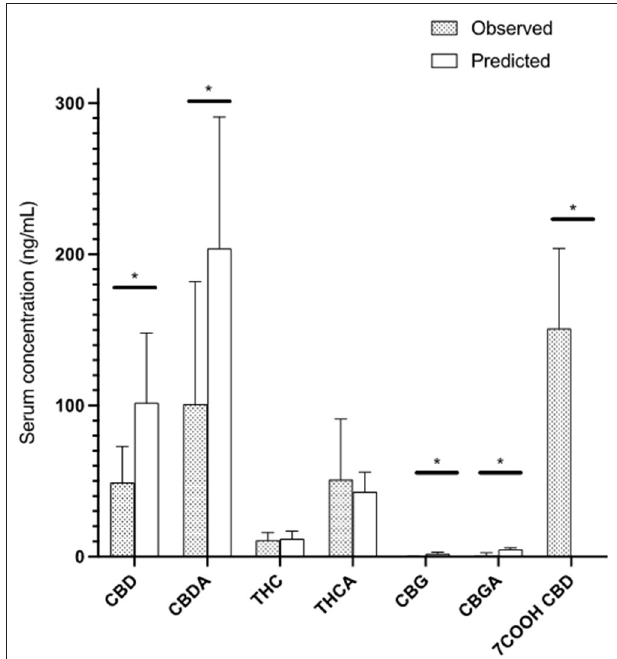
FIGURE 3 | All cannabinoids at 6-h post 13th dose showing observed steady state concentrations in serum of cats compared to predicted steady state after 5 half-life of administration based on the 24-h pharmacokinetic analysis (Mean and standard deviation). * represents a statistically significant difference ( P <